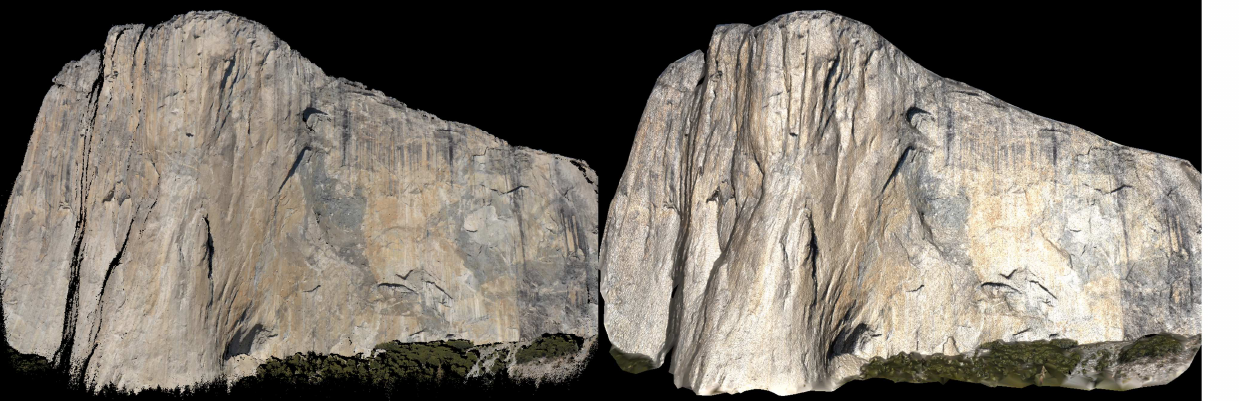
Fig. 3.4: Left: resulting point cloud after stereo models selection and dense image matching with SURE. Right: triangle mesh derived from point cloud. Point cloud count original: 146 Mio. pts. Filtering with maximum occurrence 1: 31 Mio. pts., mo 2: 18 Mio. pts., mo 4: 11 Mio.